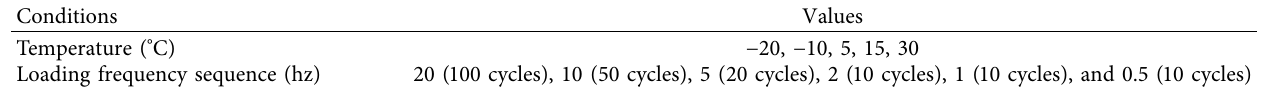
Table 4: Detailed experiment